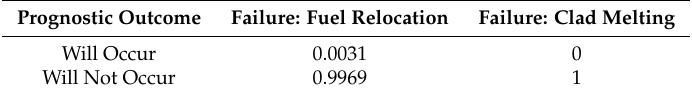
Table 6. Prognostic outcome for reactor with high power-to-flow reading, followed by high power-to-flow and outlet temperature readings, and then high power-to-flow, outlet and inlet temperature measurements at Time